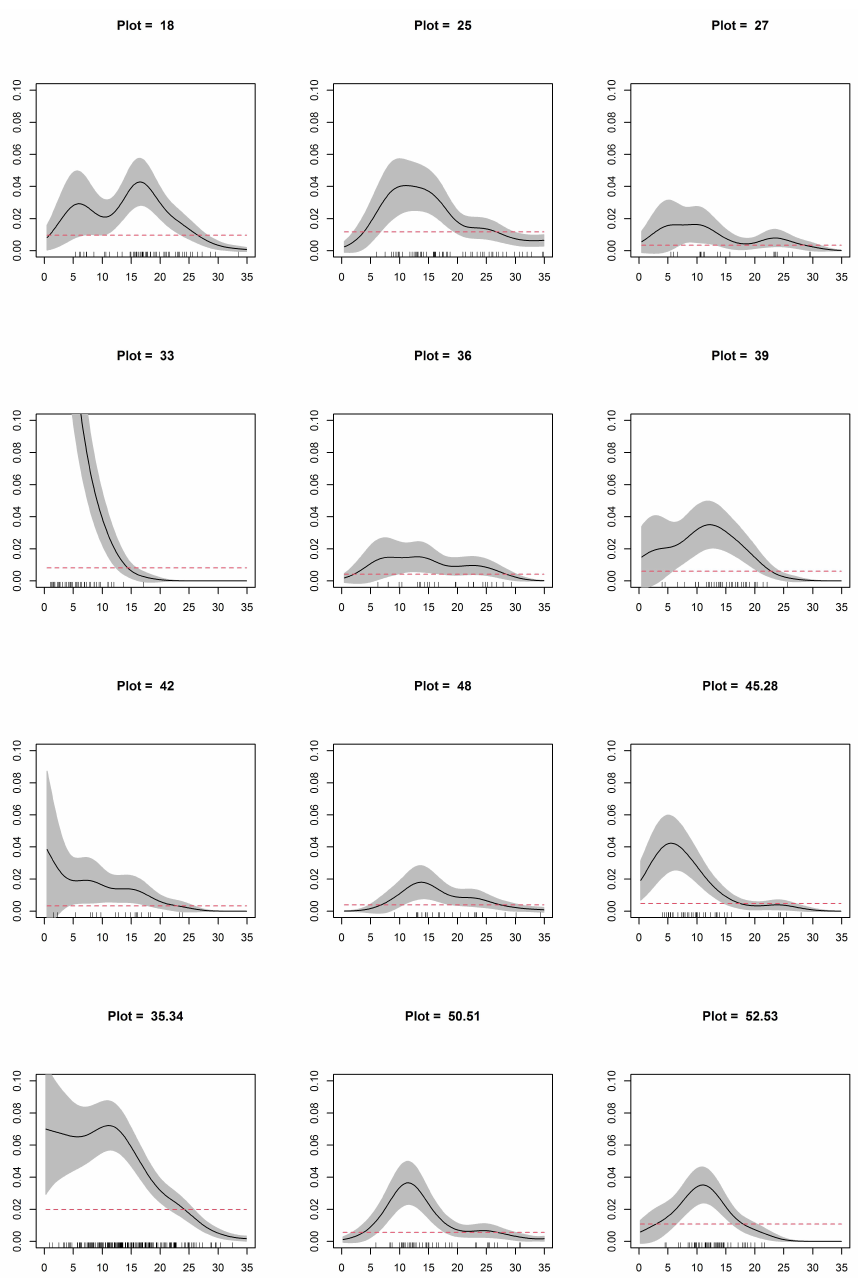
Figure 4. Estimated intensity of regeneration as a function of the distance to the nearest seed tree. The solid black line represents the estimated function ( ρ (z)), the red dotted line represents the mean, and pointwise 95% confidence intervals for the true value are plotted as grey shading.